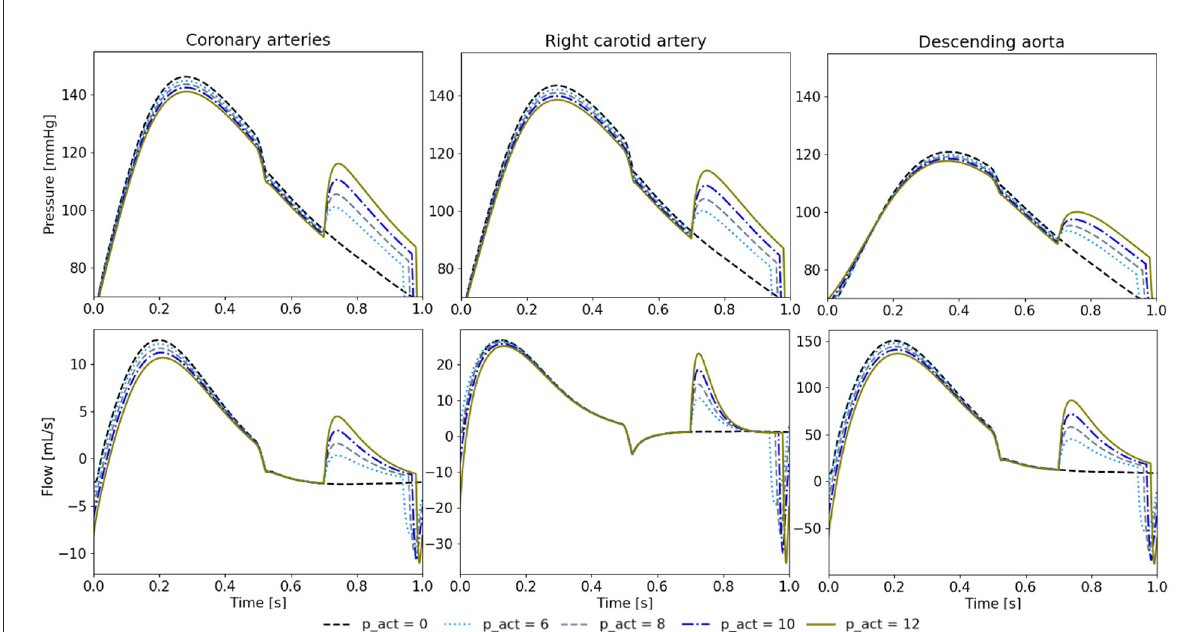
FIGURE8 Pressure and flow waveforms in the coronary and carotid arteries and the descending aorta for 650 ms of delay and different p sr in psi. All the measurements presented in this figure are made at the interaction of the last vessel element of the branch of interest and its proximal RCR